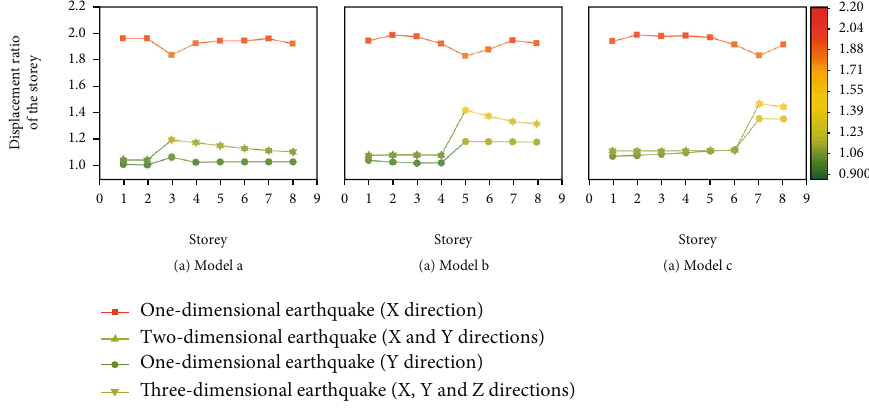
Figure 6: Floor displacement ratio in Y -direction of di ff erent models under di ff erent dimensional